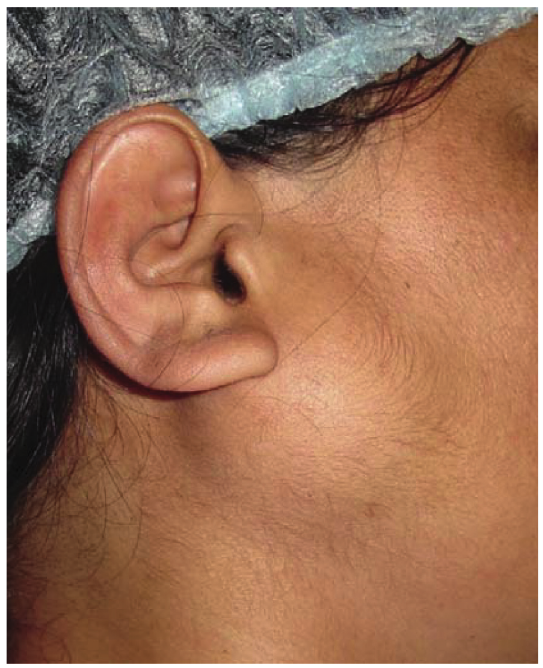
Figure 1: Preoperative clinical picture showing the well-defined swelling infra-auricular region.